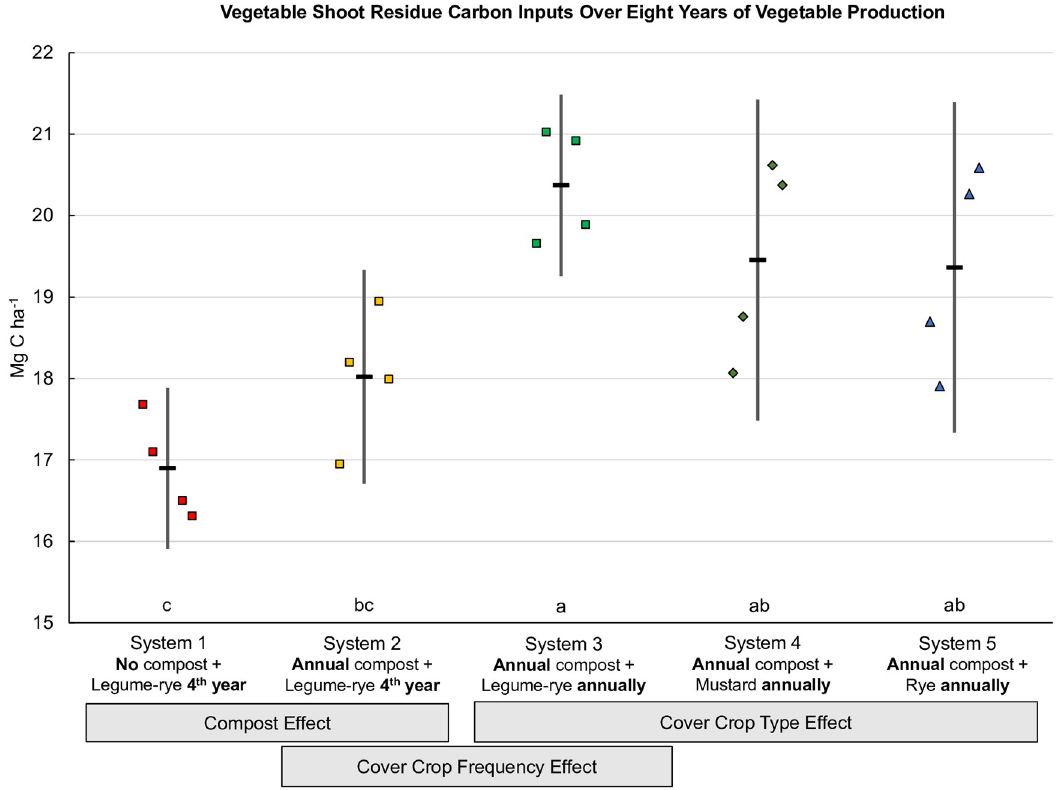
Fig 3. Vegetable shoot residue carbon inputs over eight years of vegetable production. Measurements were taken in five organic vegetable systems in Salinas, CA. Systems differed by annual compost additions (0 vs. 7.6 Mg ha -1 before each vegetable crop), cover crop type (legume-rye, mustard, or cereal rye alone) and cover cropping frequency (quadrennially vs. annually planted). Error bars are 95% confidence limits. Individual data points for reps 1 through 4 of each system are clustered in order from left to right around the mean, which is represented by the horizontal lines. Different lower case letters above the x-axis indicate that the shoot carbon means are significantly different based on the Tukey-Kramer adjusted family-wise error rate of (P � 0.05). Mean vegetable residue shoot carbon inputs (Mg ha -1 ) were 16.9 (System 1), 18.0 (System 2), 20.4 (System 3), 19.5 (System 4) and 19.4 (System